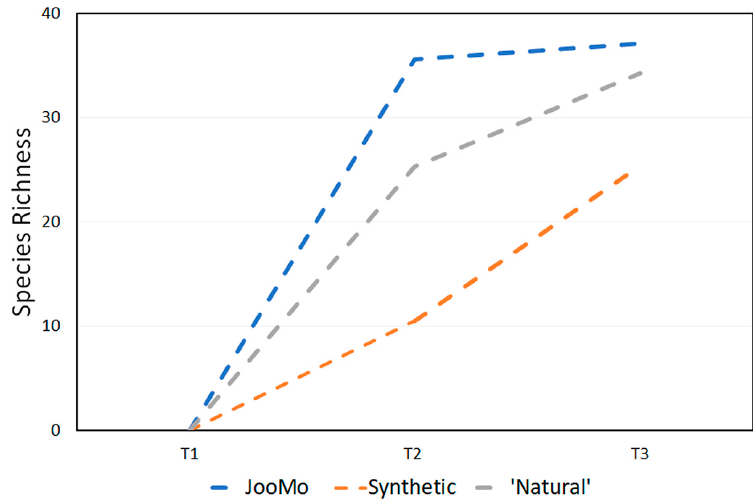
Figure 4. Average change in species richness at every time point. Table 2. Percentage change in Chao1 diversity for all product groups. Table 3. Percentage change in richness for all product groups.